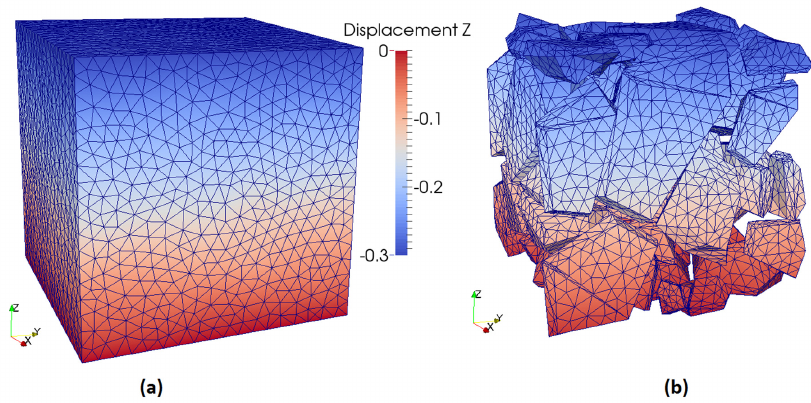
Figure 3. Case #1 simulation. Single block mesh. ( a ) mesh view; ( b ) view of aggregate elements.